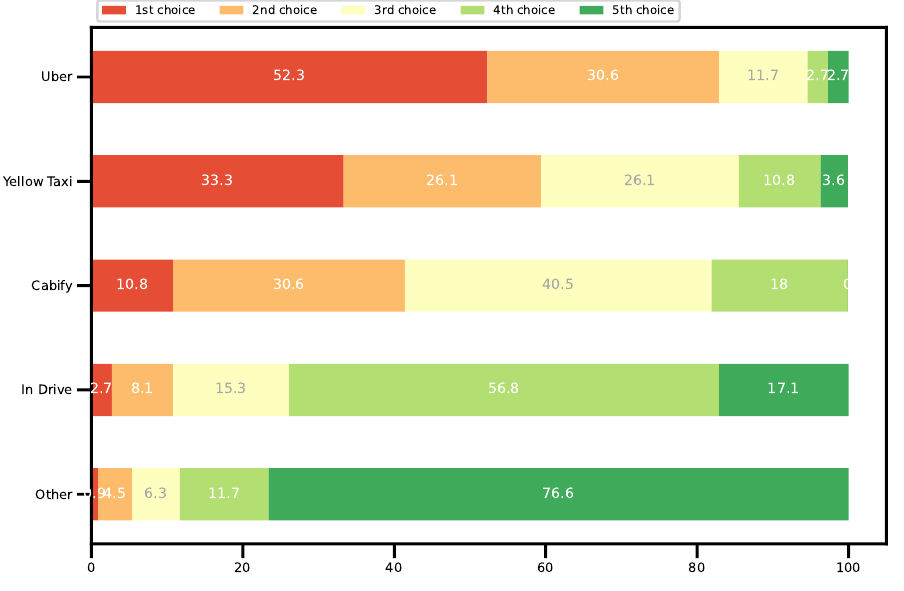
Figure 1. Bar chart of the preferences of service types of